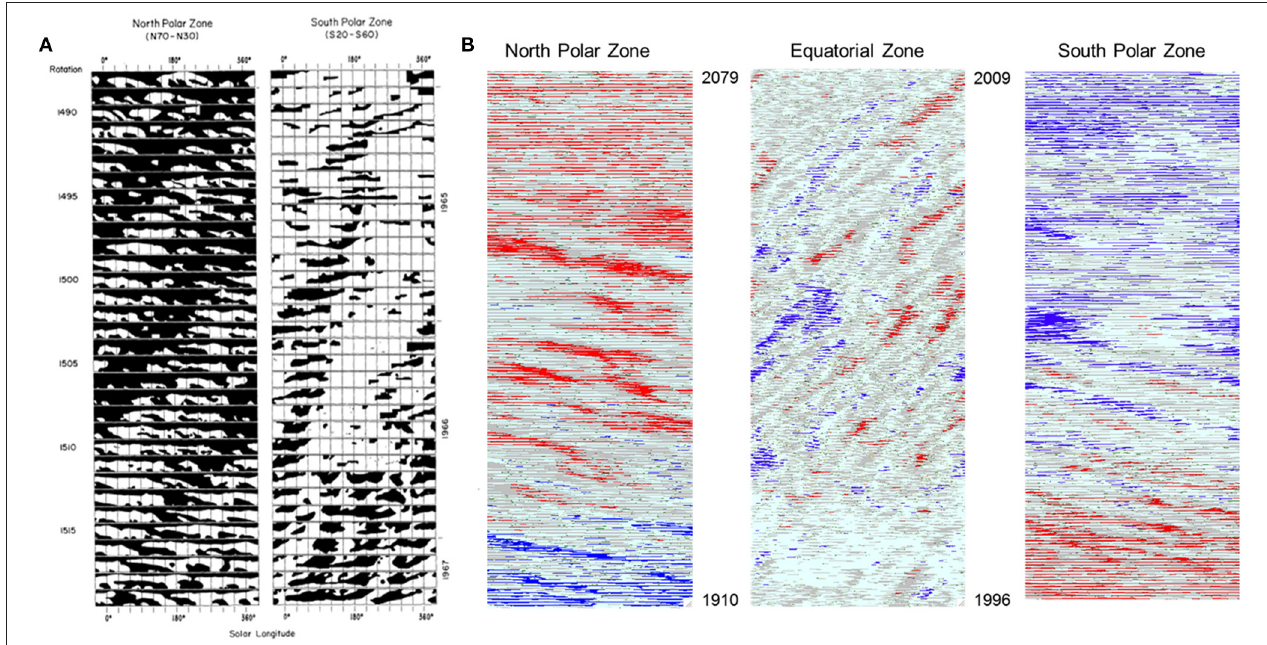
FIGURE 3 | (A) Figure by P. McIntosh displaying the large-scale polarity patterns for high solar latitudes for 1964–1967 comparing north and south poleward zones for each 360 ◦ CR. The barber-pole patterns denote the varying rotation rates of the patterns. (B) The same stack-plotting, but for the entire McA SC 23 (13